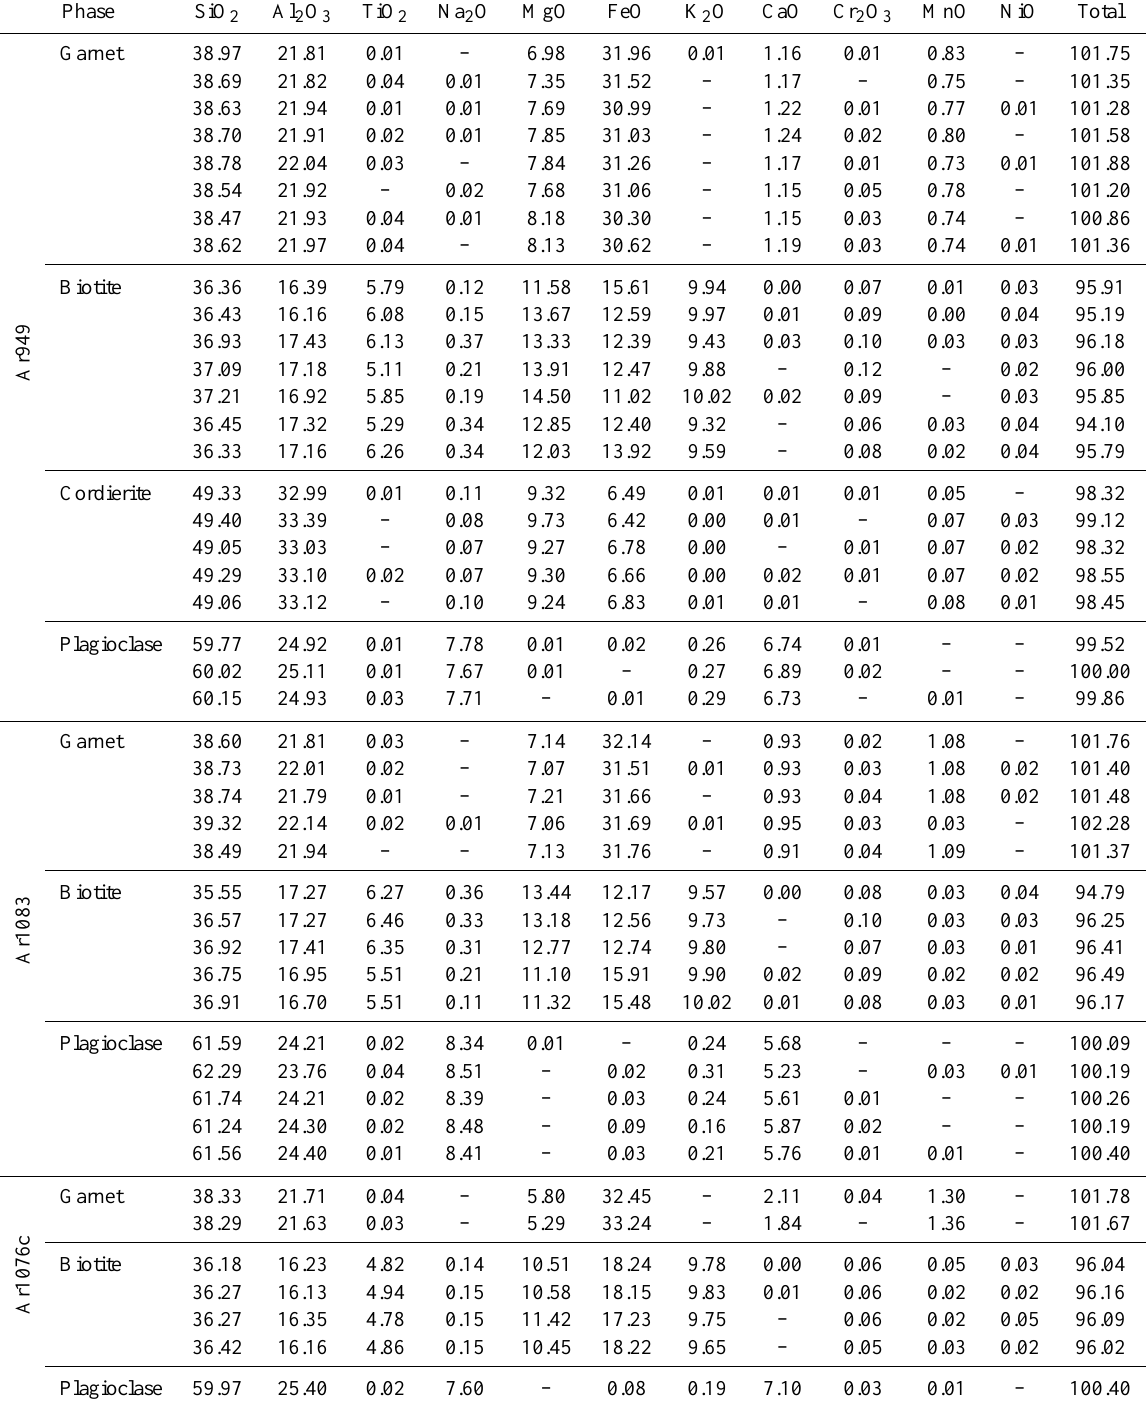
Table 3. Summarized oxide mineral chemistry for the studied rocks, including the major element composition (wt%) of selected garnet, biotite, plagioclase, orthopyroxene and cordierite. ∗ – = content lower than the detection limit. Phase Garnet